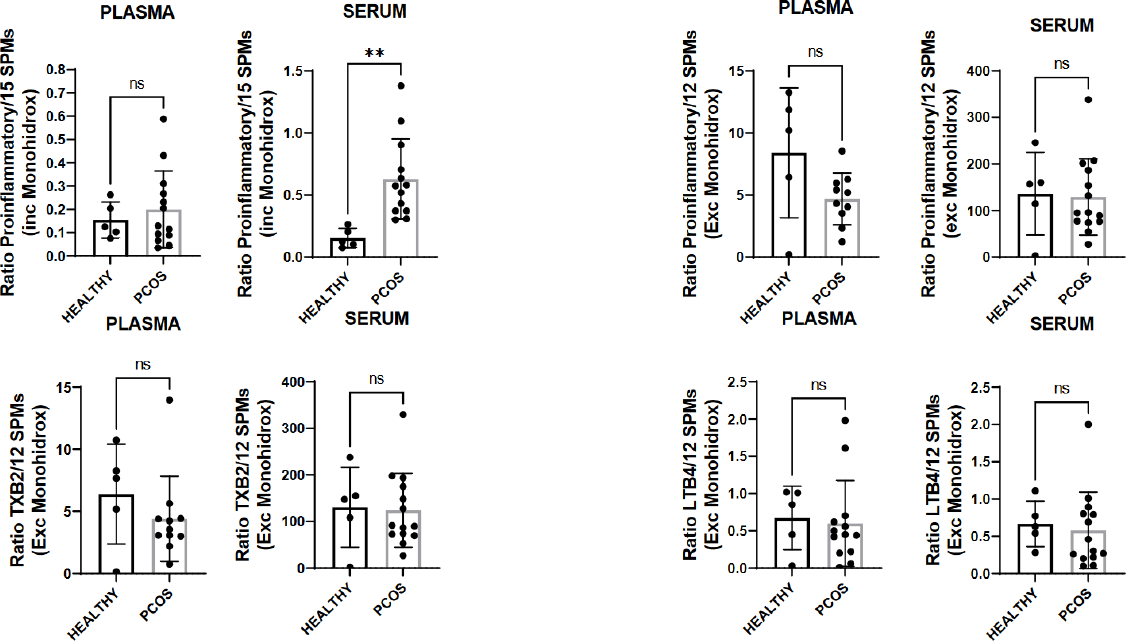
Figure 3. Results of the ratio pro-inflammatory parameters/SPMs, including the monohydroxylates in the serum compared to the plasma. ns = not significant; ** p < 0.005.